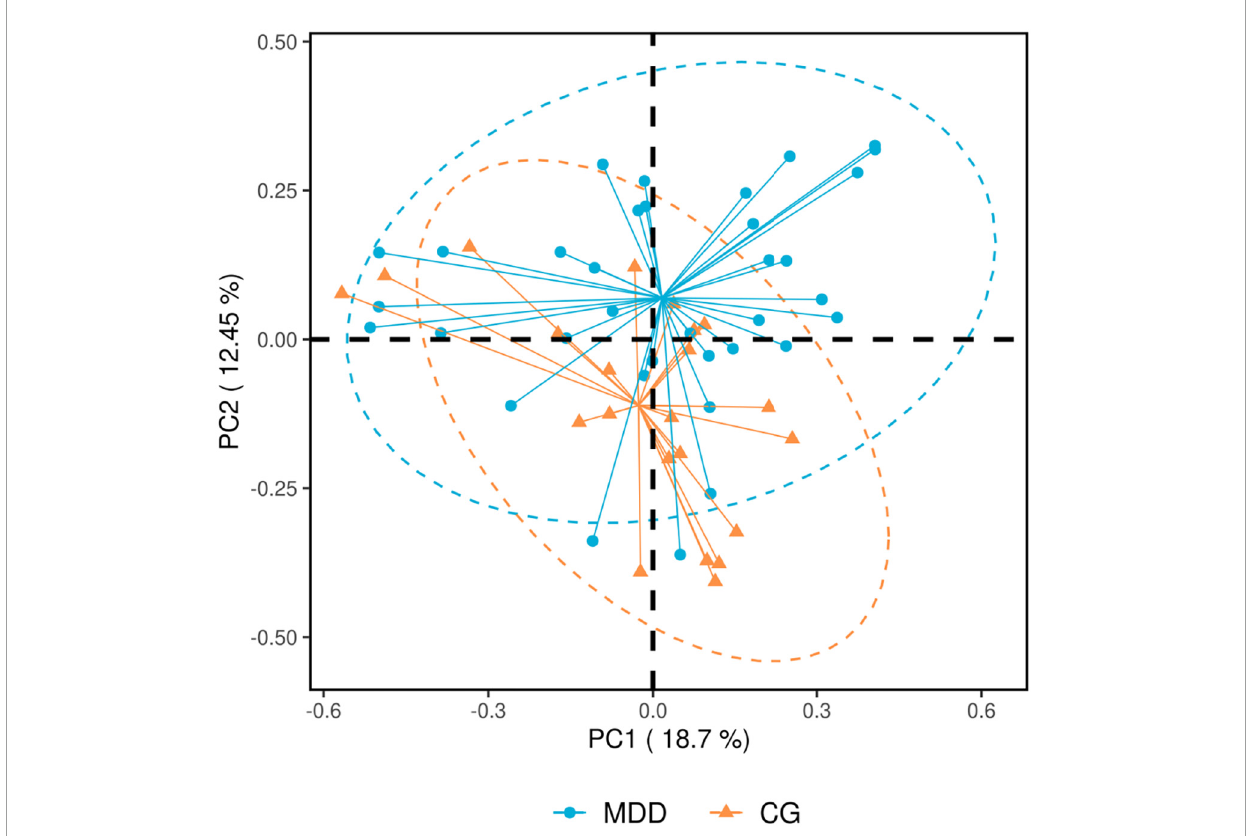
FIGURE4 Principal component analysis results. Each spot in the figure represents a sample. The blue spots refer to the major depressive disorder group (MDD group), and the orange spots refer to the healthy control group (C group). The closer the distance between spots, the more similar the samples. Principal component analysis is sequencing analysis based on the species abundance matrix of samples, with the abscissa axis and the ordinate axis representing the contribution rate of principal component 1 (PC1) and principal component 2 (PC2), respectively.